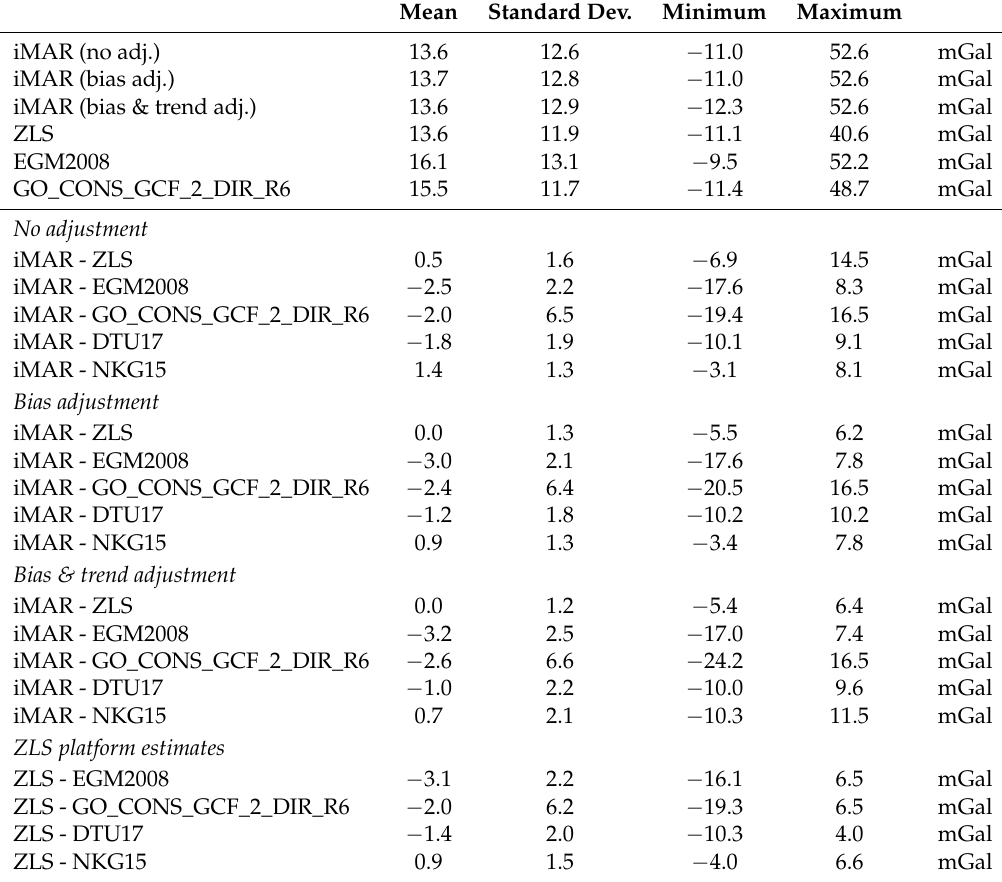
Table 4. Mean, standard deviation, minimum and maximum of gravity estimates and global models, along with the difference between airborne estimates and external gravity information. Mean Standard